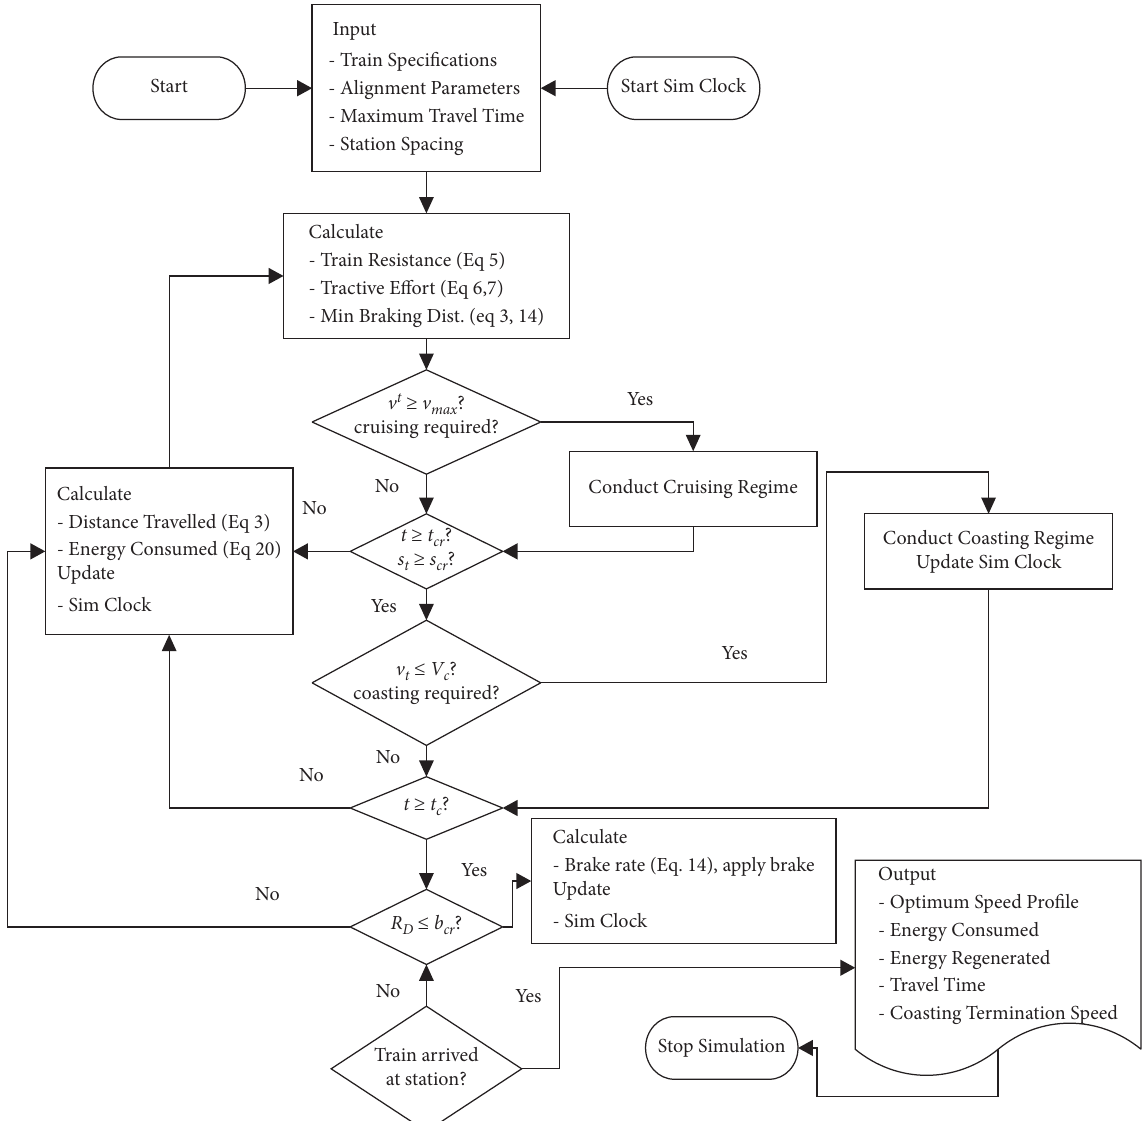
Figure 1: Flowchart for simulation of the train